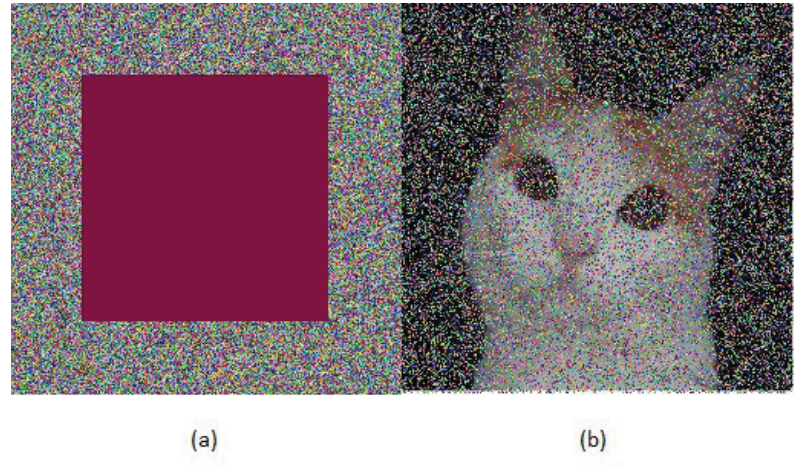
Figure 6. Vicky cat image ( a ) ciphered using ICLEBF with 40% occlusion damage and ( b ) is the deciphered image.